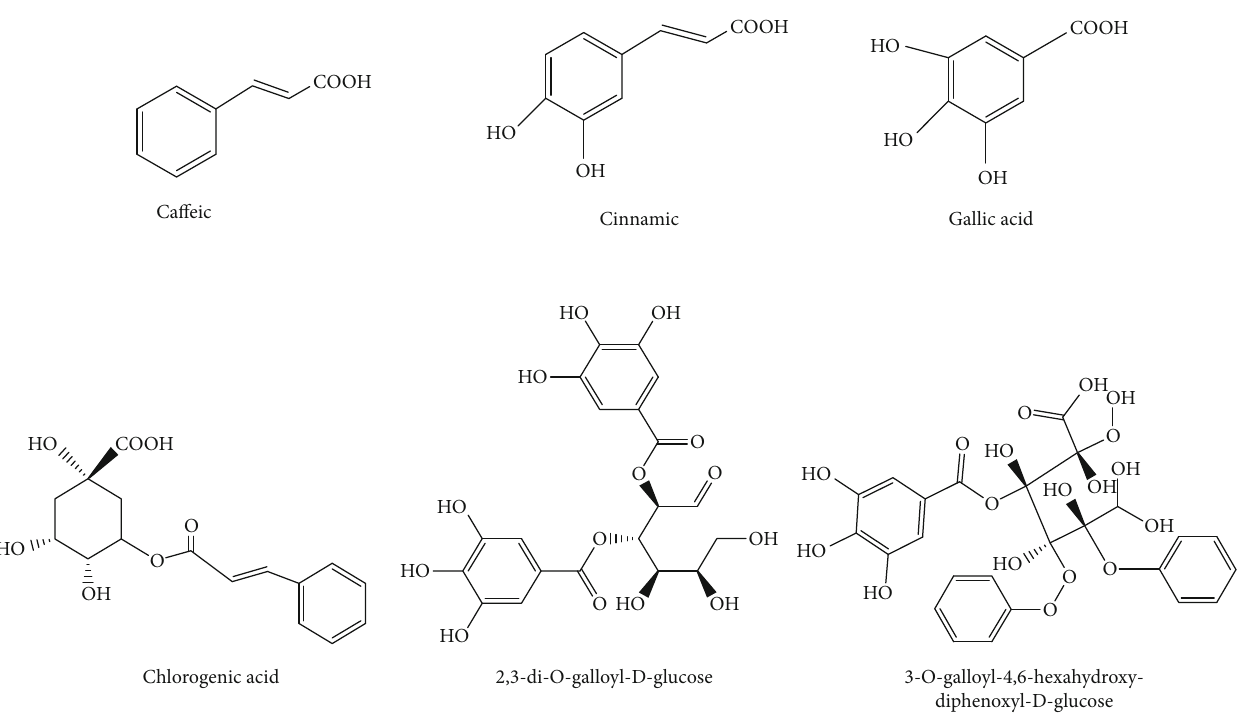
Figure 5: Cinnamic derivatives isolated from P. lanceolata